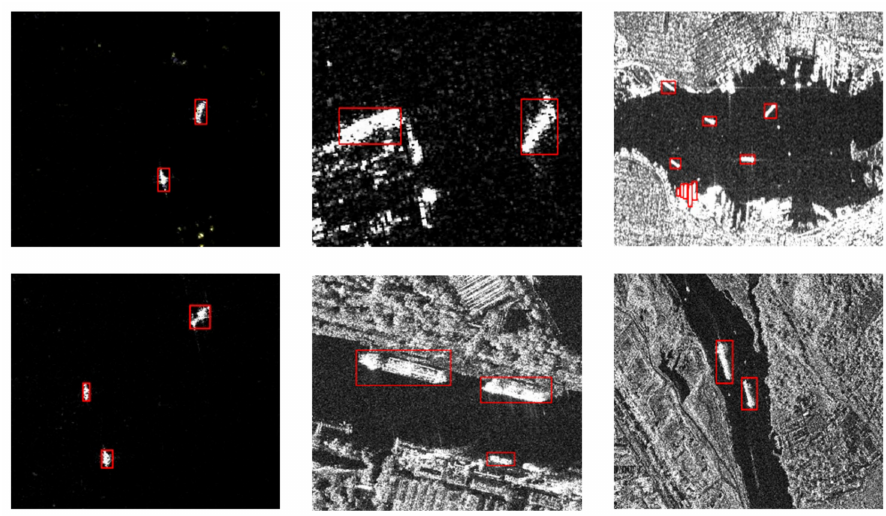
Figure 6. SSDD sample, in which ship targets in large areas of the sea, offshore areas, and complex background are listed in column 1, column 2, and column